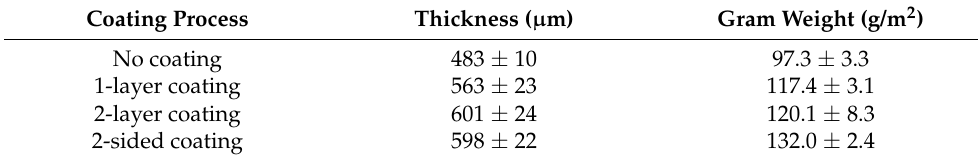
Table 1. Fundamental properties of nonwoven and composites from various coating processes.